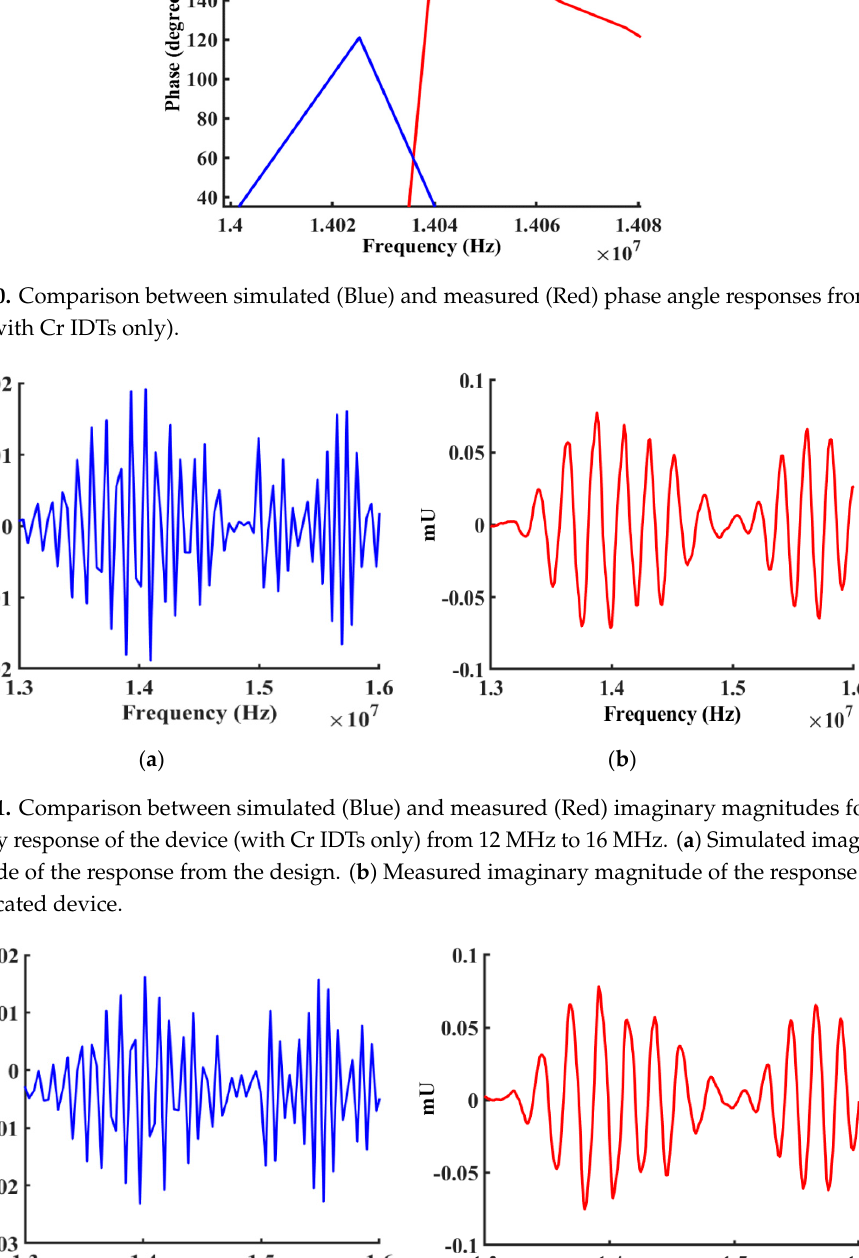
Figure 12. Comparison between simulated (Blue) and measured (Red) real magnitude responses for the device (with Cr IDTs only) from 12 MHz to 16 MHz. ( a ) Simulated real magnitude of the response from the design. ( b ) Measured real magnitude of the response from the fabricated device.